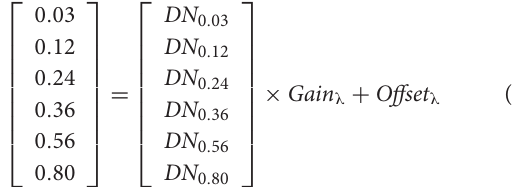
Figure 2D , 92.1 vs. 56.3%) per panicle, and grain yield per plant (GYP, Figure 2E , 38.5 vs. 20.6) of LY9348 were higher than those of FLY4H in the 0 kg/ha N treatment and in the 120, 180, and 240 kg/ha N treatments. Grain yielding per kg N, an evaluation parameter for NUtE, indicated that LY9348 produced higher